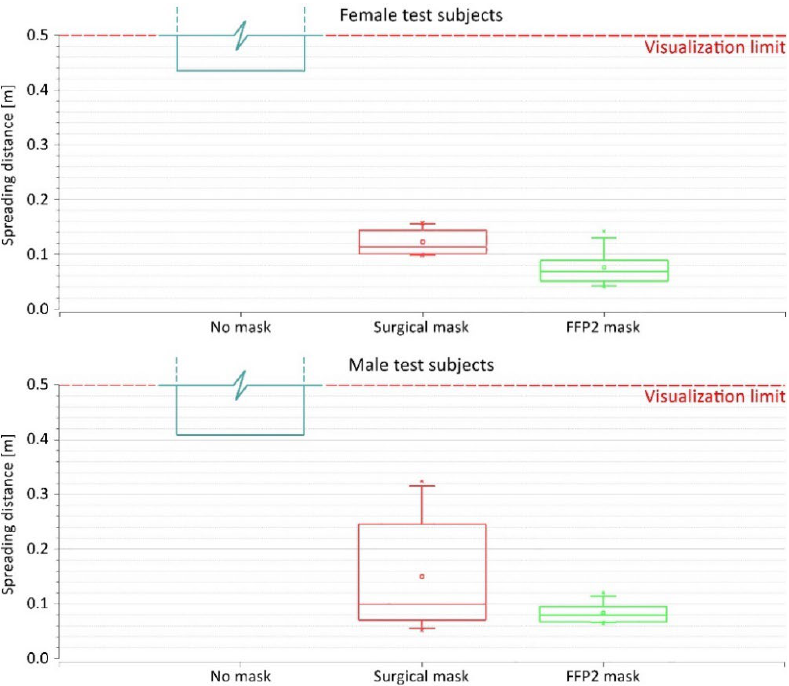
Figure 7. The spreading distance of exhaled air from the female and male test subjects when wearing no mask, surgical mask, and FFP2 mask.